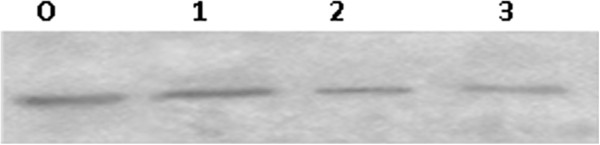
The protein expression of COX-2 by western blotting (0.The control group, 1. Lipofectin group, 2. COX-2 AS-ODN: 100 nmol/L, 3. COX-2 AS-ODN: 400 nmol/L).